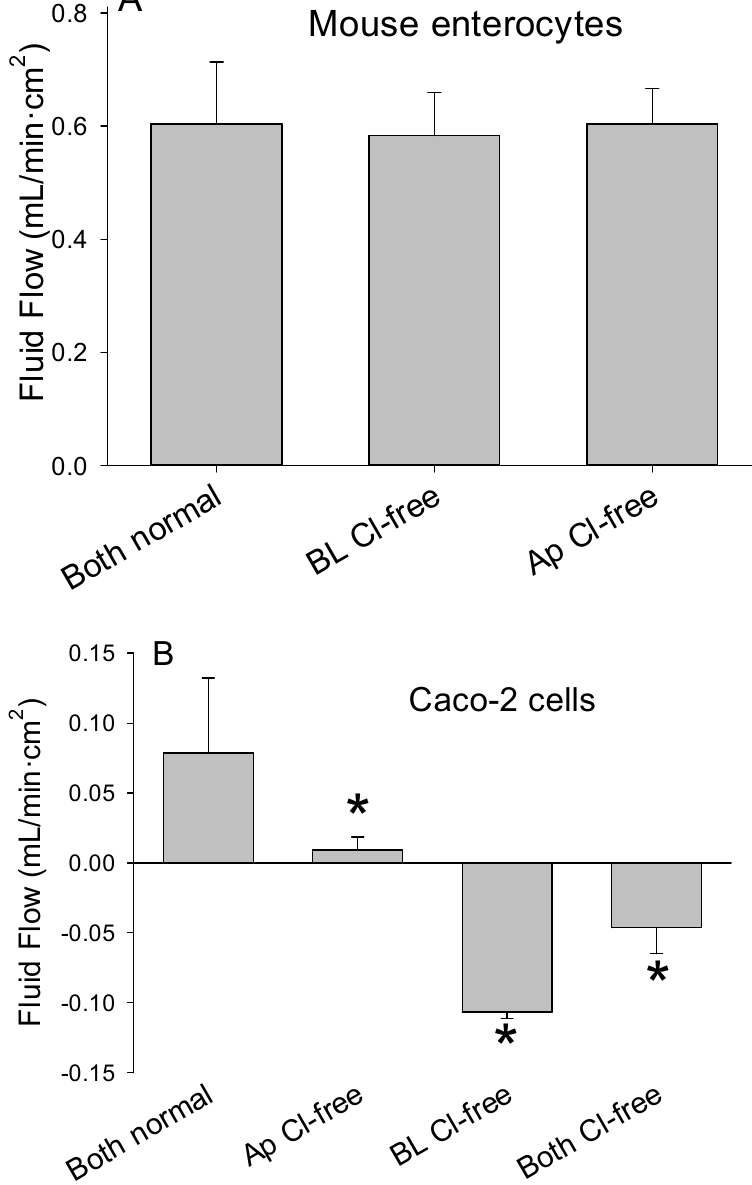
Figure 7. ( A ) Enterocytes harvested from two mice were cultured on inserts with 12 µm pores ( n = 6 per mouse). Fluid flow to the apical chamber after 5 min of vigorous aeration did not differ when measured with normal Ringer’s solution in both chambers, or when chloride-free Ringer’s solution was added to the basolateral (BL Cl-free) or to the apical (Ap Cl-free) chamber. ( B ) Caco-2 cells were cultured on inserts with 12 µm pores ( n = 8). Fluid moved from the basolateral to the apical chamber (positive value) in response to vigorous aeration with normal Ringer’s solution in both chambers (both normal), though significantly less than cultured enterocytes. Fluid movement to the apical chamber was reduced when Cl-free Ringer’s solution was added to the apical (Ap Cl-free) and actually reversed when added to the basolateral (BL Cl-free) or to both chambers (both Cl- free). * p < 0.05 for comparison with normal Ringer’s solution in both